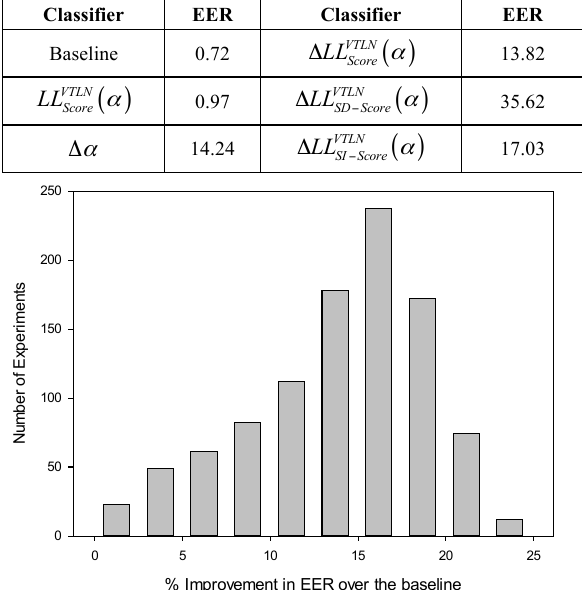
TABLE I. EER FOR THE SELECTED CLASSIFICATION METHODS